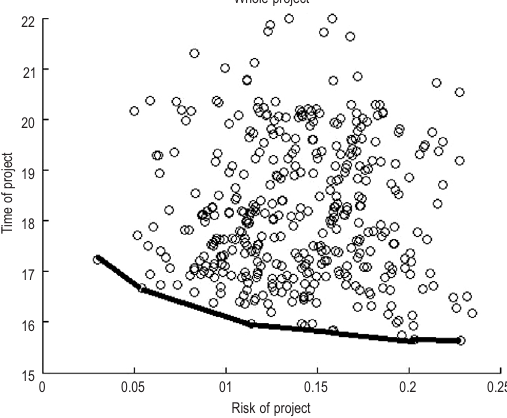
Fig. 9. The interaction of time and risk